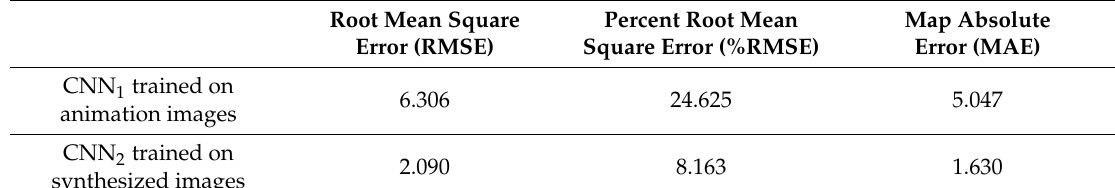
Table 2. The test performance of two CNNs when applied to real-world photos.